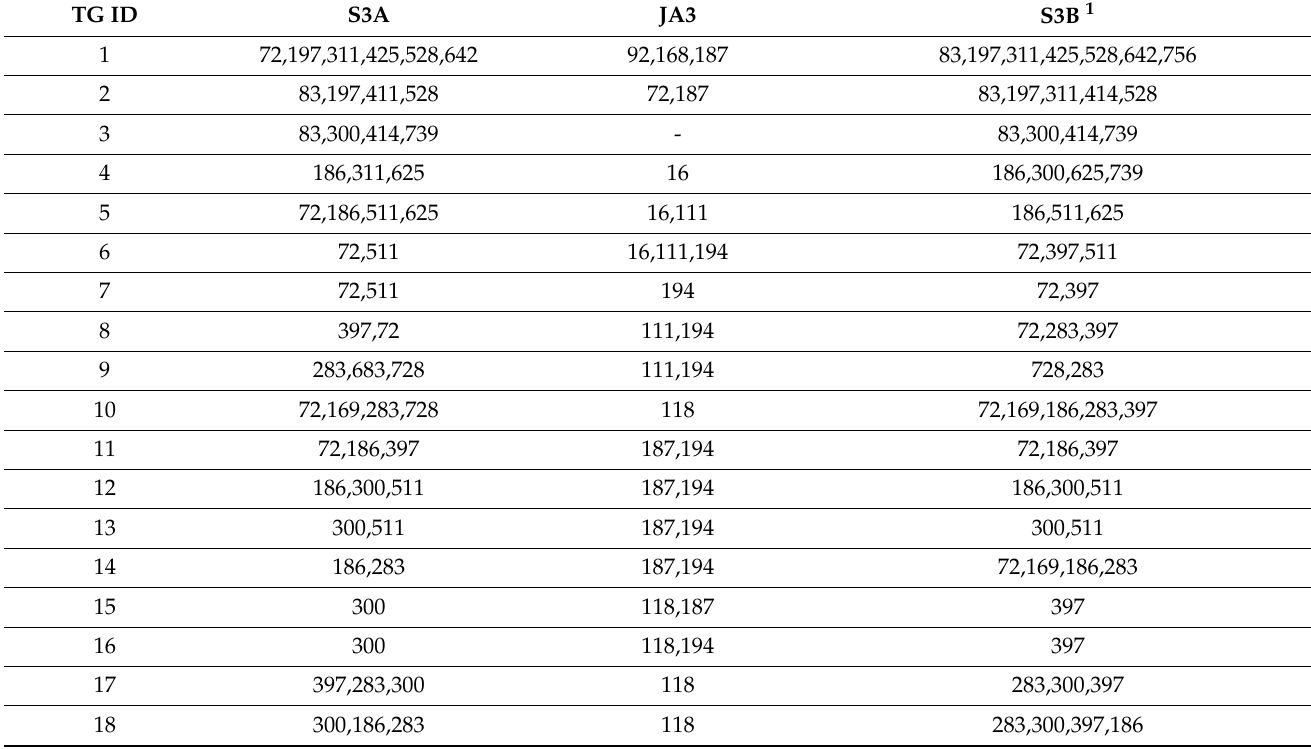
Table A2. SA pass numbers nearby used TG